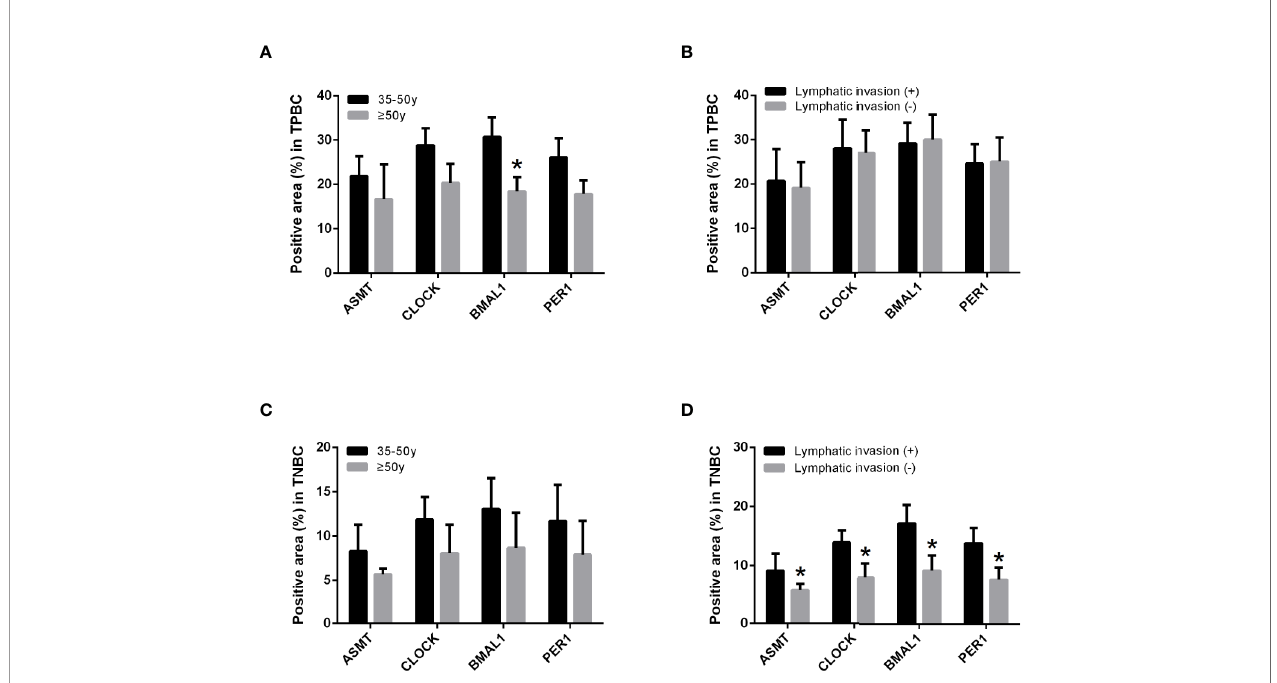
FIGURE 5 | ASMT expression and the circadian clock system expressions correlate positively with lymphatic invasion in TNBC. (A) Only BMAL1 expression levels decreased in the elder TPBC. (B) Expression levels of ASMT and the circadian clock proteins do not change with lymphatic invasion in TPBC. (C) Expression levels of ASMT and the circadian clock proteins do not change with age in TNBC. (D) Expression levels of ASMT and the circadian clock proteins are higher with lymphatic invasion in TNBC patients. Data are the mean ± SEM (TPBC, n = 30; TNBC, n = 25). * p <